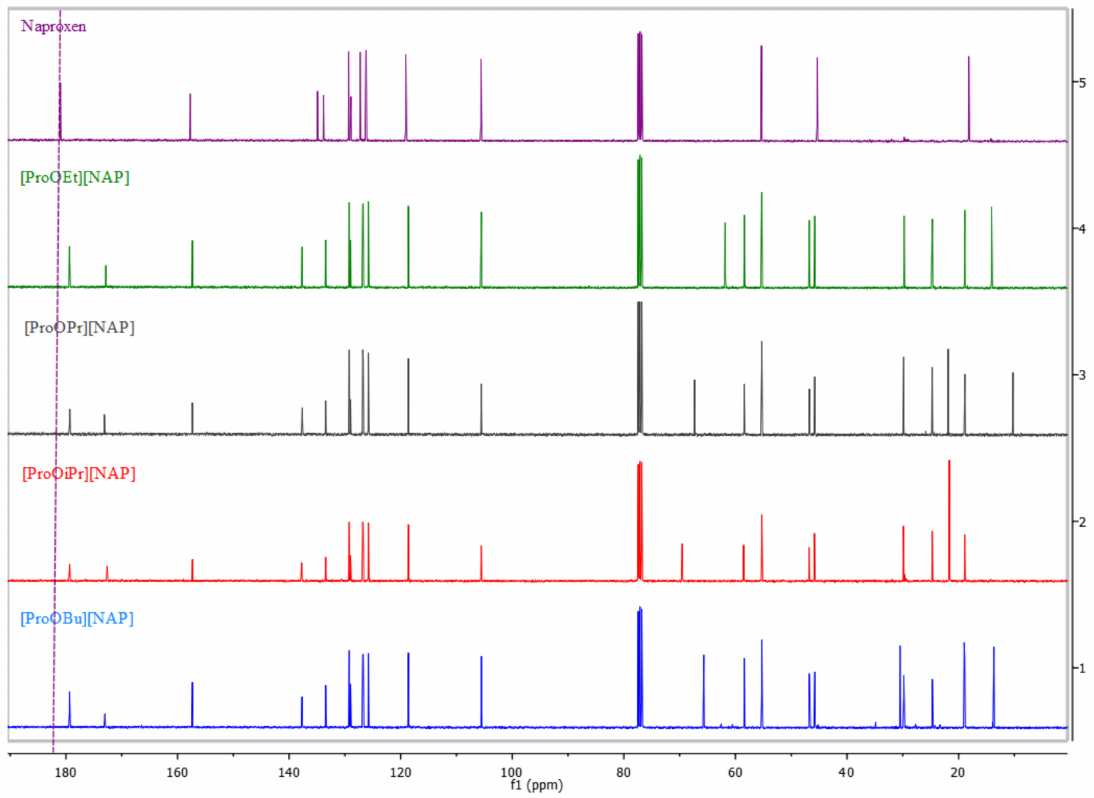
Figure 2. 13 C NMR spectra for naproxen (purple), [ProOEt][NAP] (green), [ProOPr][NAP] (black), [ProOiPr][NAP] (red), and [ProOBu][NAP] (blue) (carbonyl carbon shift in naproxen is highlighted in